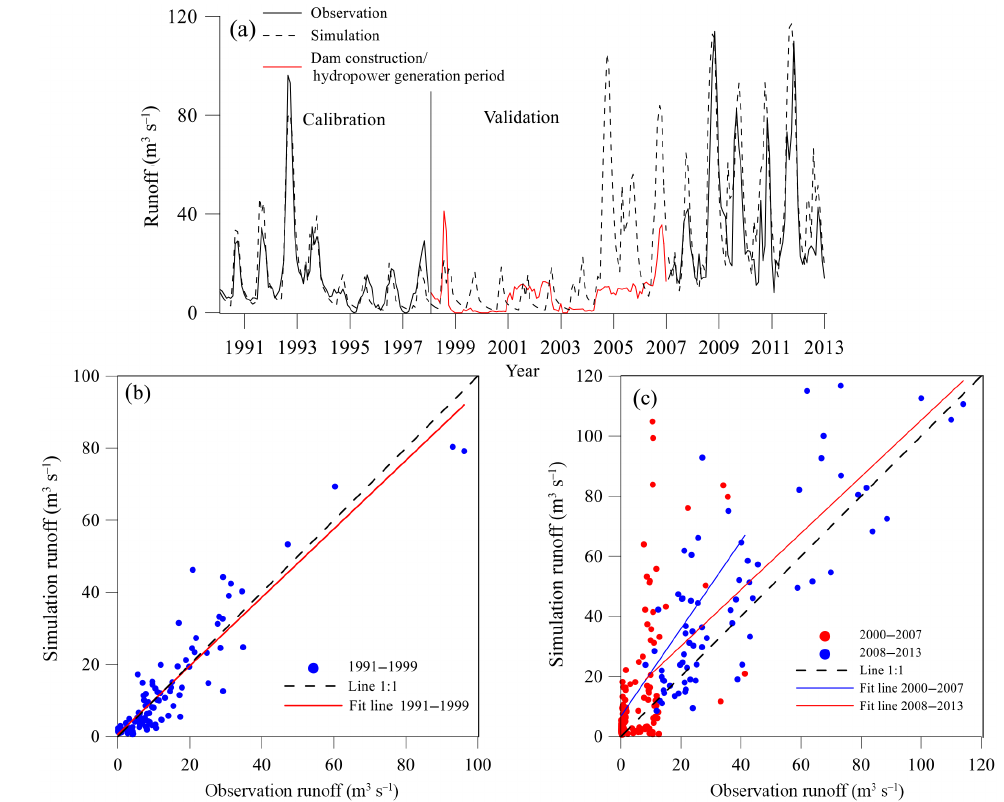
Figure 5. Comparison between simulation and observation runoff.